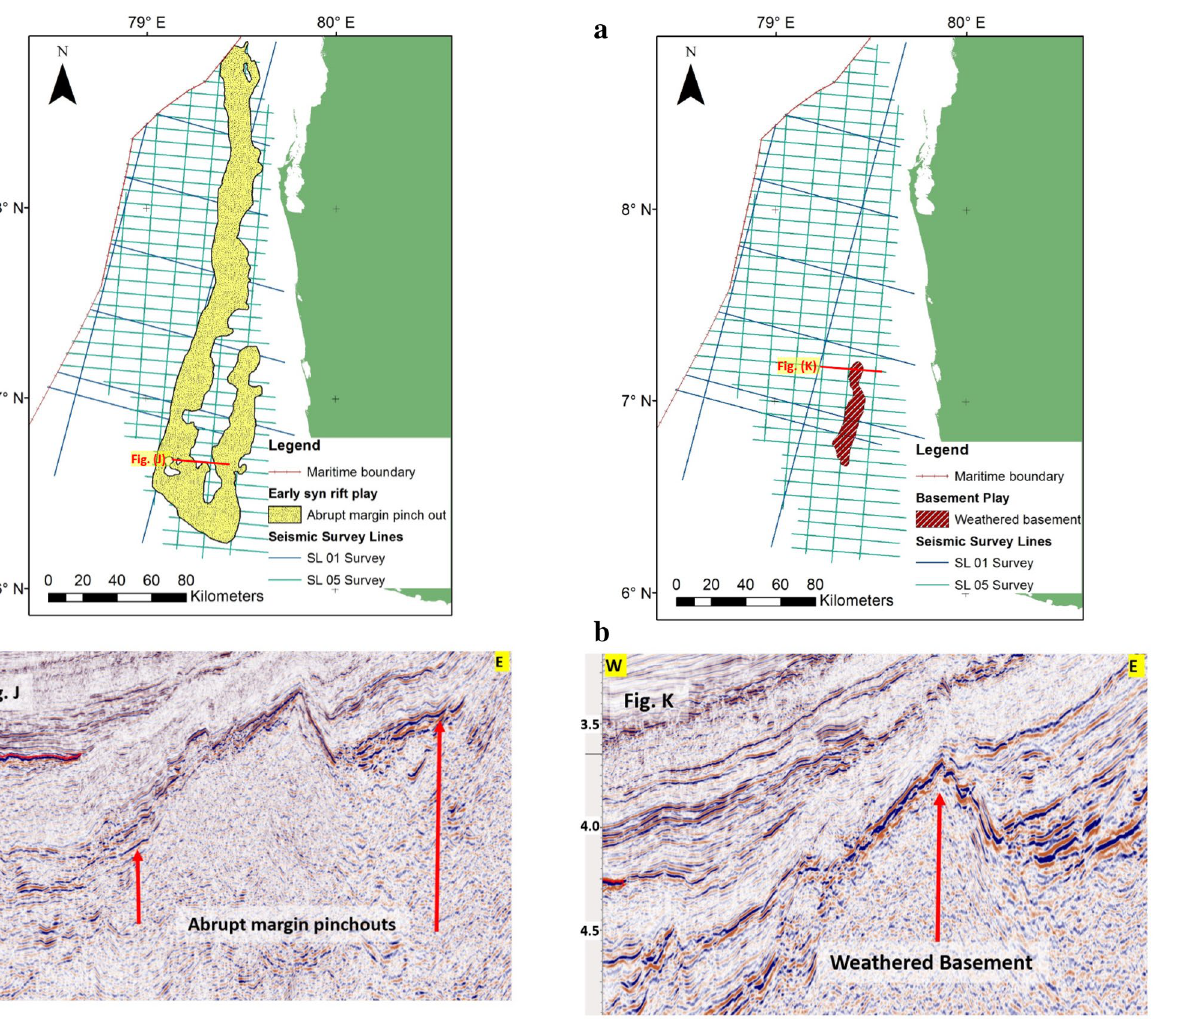
Fig. 13 a Map showing the distribution of the early syn-rift plays in the Mannar Basin. b Seismic profile showing the early syn-rift play, (J) abrupt margin pinchouts